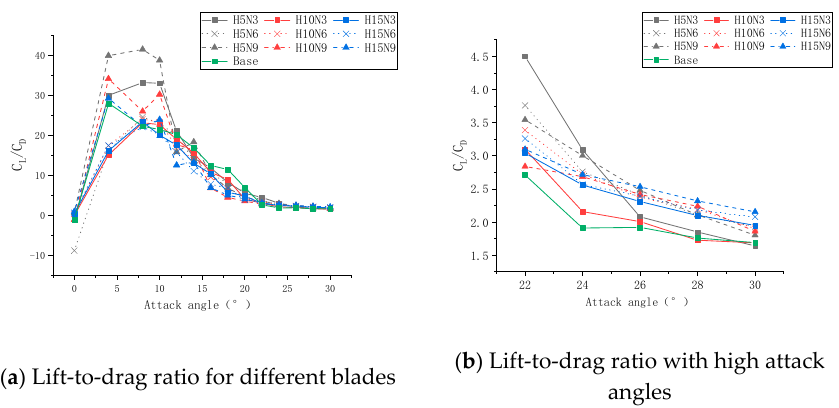
The drag on the base blade increases as the attack angle increases (Figure 8). The same trend is observed for all other blade models. The leading-edge tubercles may produce a difference in the drag coefficients within a range of ± 0.05. The corresponding lift-to-drag ratio is plotted in Figure 9. Figure 9b is the zoomed-in plot for the cases with high attack angles. Similar to [12], a better lift-to-drag ratio may be achieved for low attack angles by introducing the tubercles. It is also not surprising to find a considerably improved lift-to-drag ratio caused by the tubercles when the blades are subjected to high attack angles (Figure 9b).